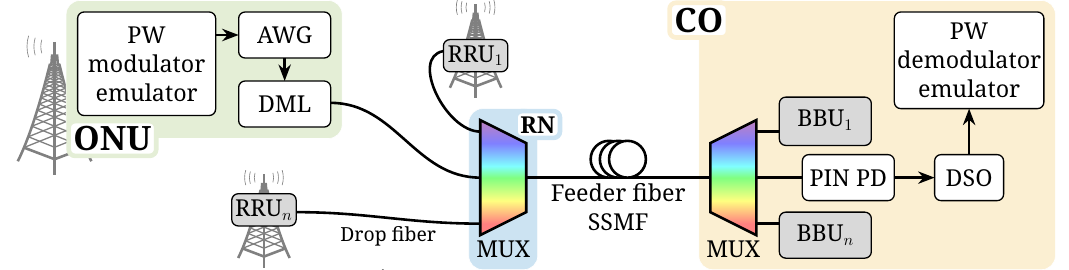
1 Figure 3. WDM-PON PWM fronthauling and experimental